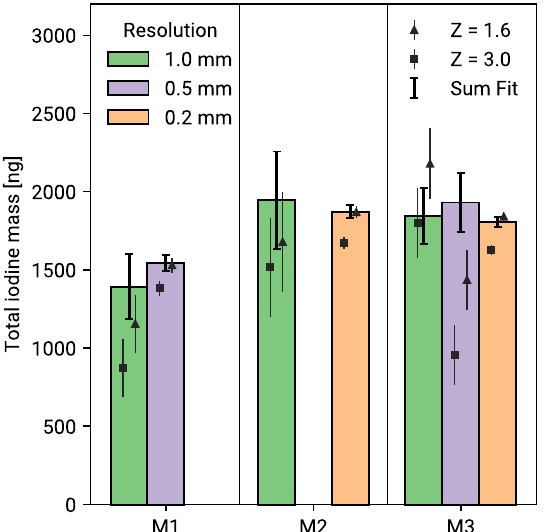
Figure 3. Total reconstructed thyroidal iodine mass for all scans. The bars show the reconstructed mass using the combined spectrum of all pixels, while the triangles and squares show the sum of the reconstructed mass per pixel for Z min = 1.6 and Z min = 3. Only statistical errors are shown. Mean and standard deviation of the combined reconstruction are shown in red.